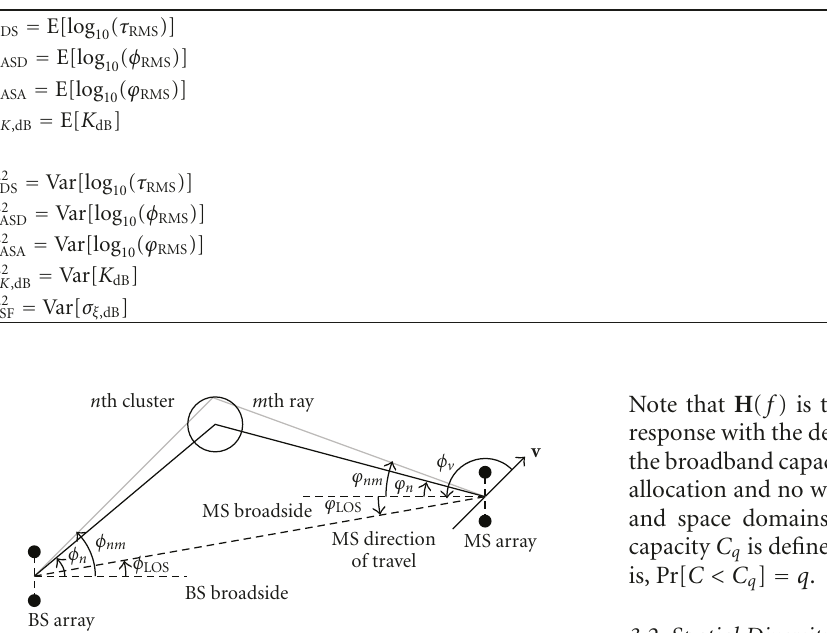
Table 1: Definitions of first- and second-order statistics of LSPs.